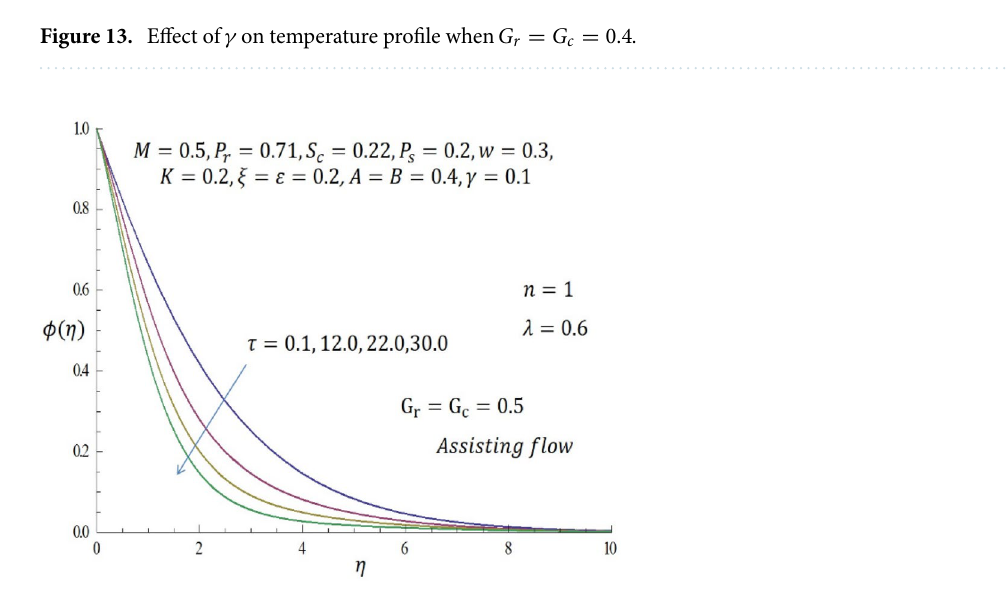
Figure 14. Effect of τ on concentration profile when n = 1